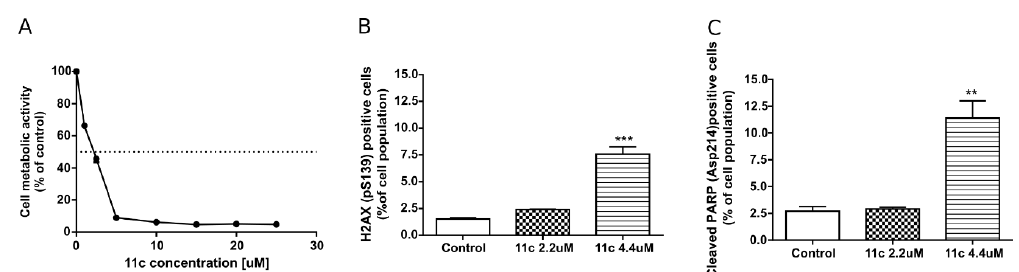
Figure 3. Influence of 11c on HL-60 cells after 24 h incubation ( A ): Metabolic activity, ( B ): DNA damage measured by H2AX phosphorylation changes and ( C ) : apoptosis induction measured by PARP cleavage. ( B , C ) : Results are expressed as mean ± SEM of a triplicate assay; *** p < 0.001, ** p < 0.01.